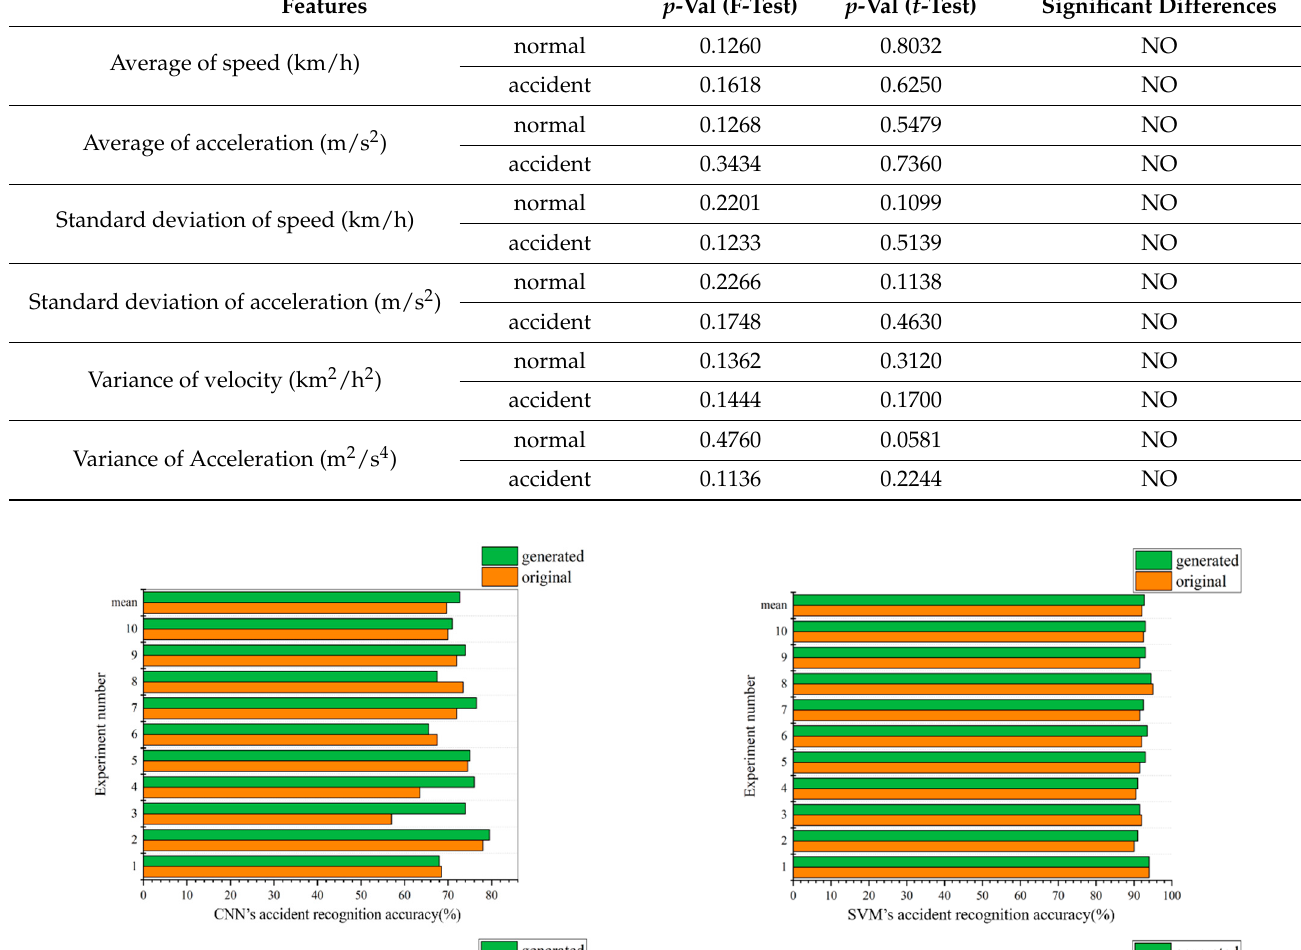
Table 6. Test for significant differences between generated and original samples.